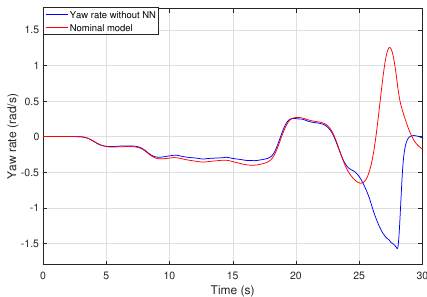
Figure 15. Yaw-rate without neural network linearization.